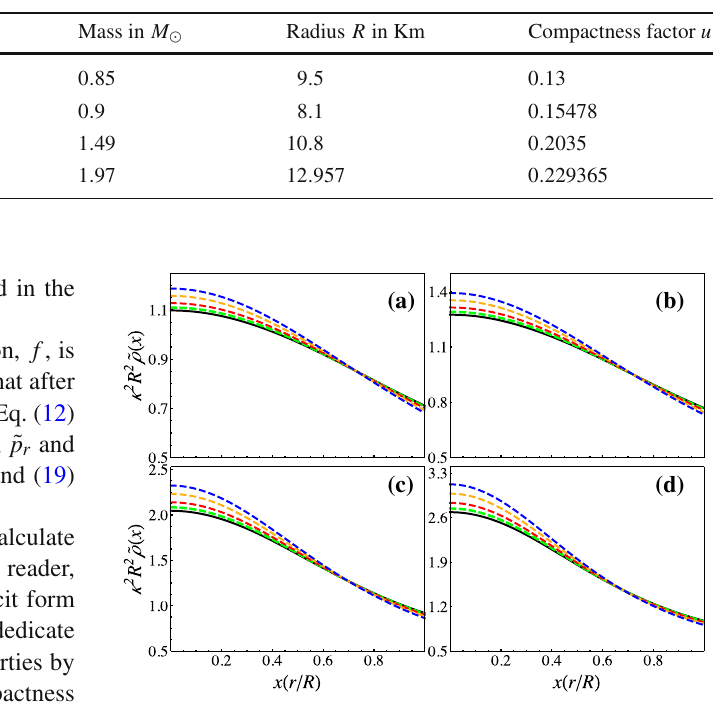
Fig. 1 Effective density ˜ ρ for a u = 0 . 13, b u = 0 . 15478, c u = 0 . 2035, d u = 0 . 229365. α = 0 (black solid line), α = 0 . 04, (green dashed line), α = 0 . 1 (red dashed line), α = 0 . 2 (yellow dashed line), α = 0 . 3 (blue dashed line)